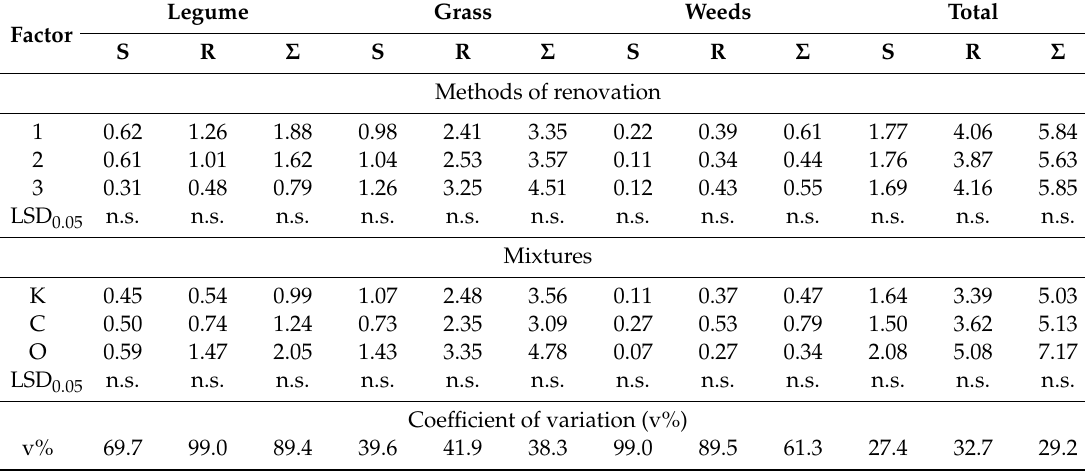
Table 3. Comparison of the dry matter of post-harvest residues by fraction (legumes plants, grasses, and weeds) as well as by stubble and roots in t · ha − 1